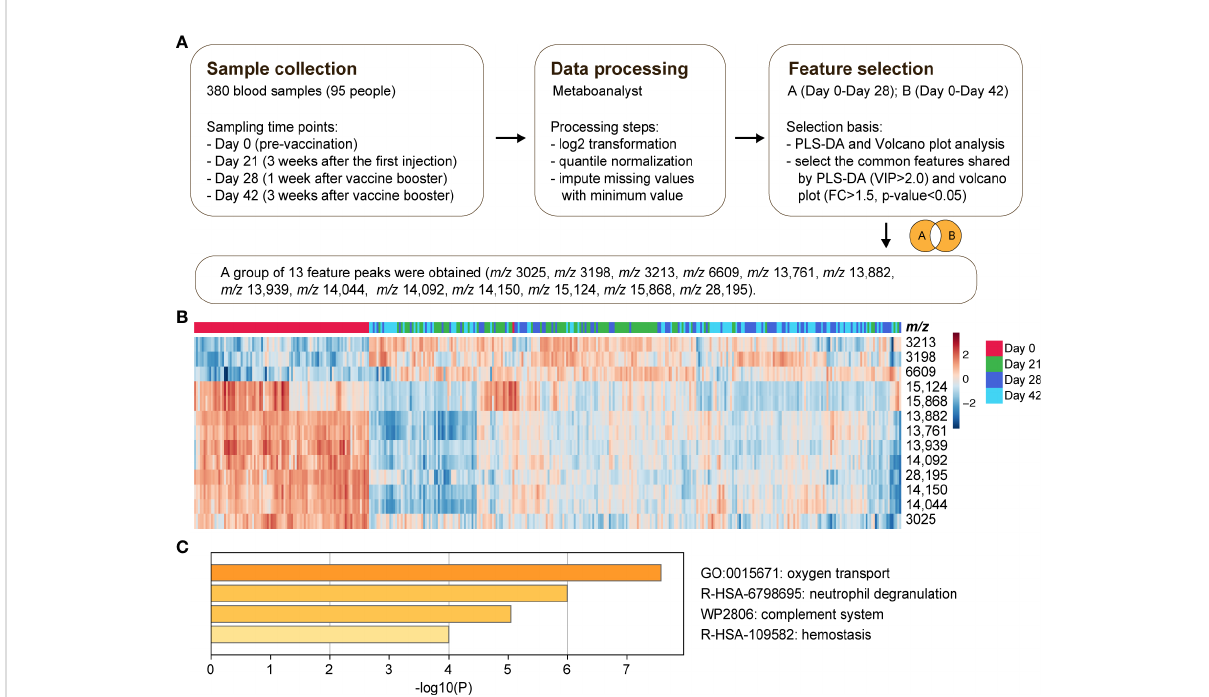
FIGURE 4 Selection of feature peaks of vaccination. (A) A general scheme of sample collection, data processing and feature selection. (B) Cluster analysis of the 13 feature peaks of vaccination among all the samples. (C) The Gene Ontology (GO) enrichment analysis by Metascape involving all the identi fi ed